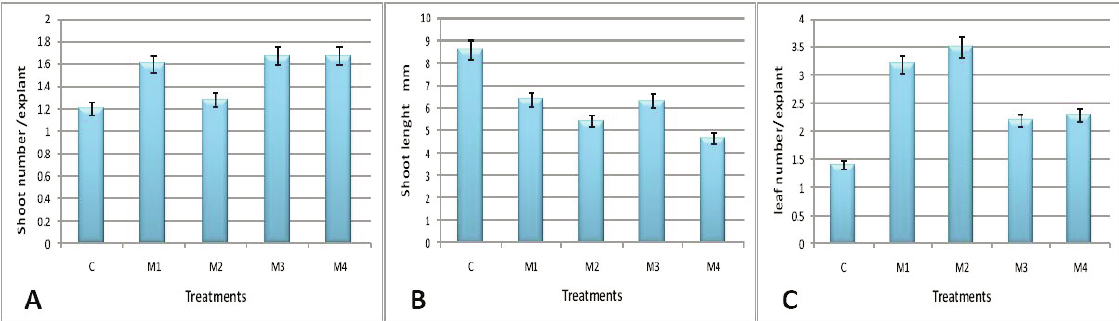
Fig. 2 - Effects of different treatments of Kn and NAA on shoot number (A), shoot length (B) and leaf number (C) per explant in ‘Bargchenari’ genotype. C= Control (no growth regulator); M1= Kn 2 mg l -1 +NAA 0.2 mg l -1 ; M2= Kn 4 mg l -1 +NAA 0.2 mg l -1 ; M3= Kn 6 mg l -1 +NAA 0.2 mg l -1 ; M4= Kn 8 mg l -1 +NAA 0.2 mg l -1 .